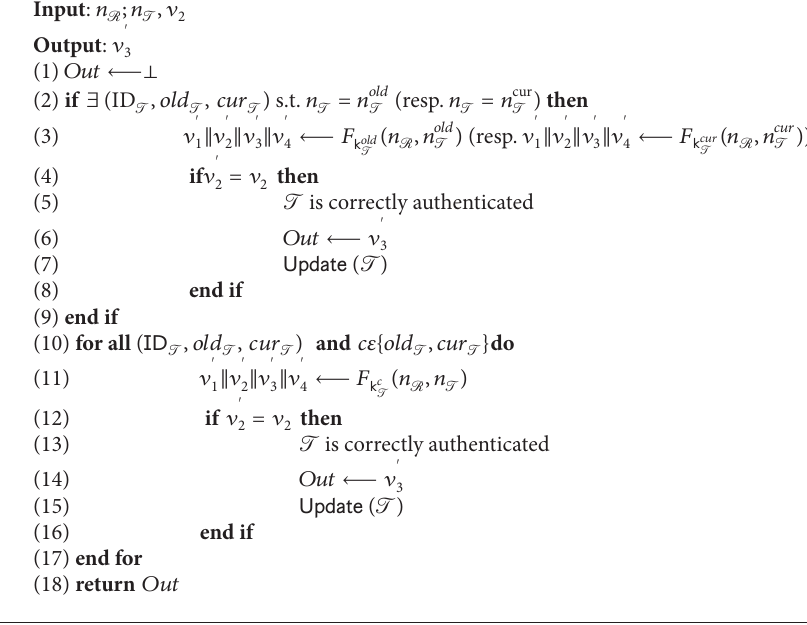
A 1: e search procedure.